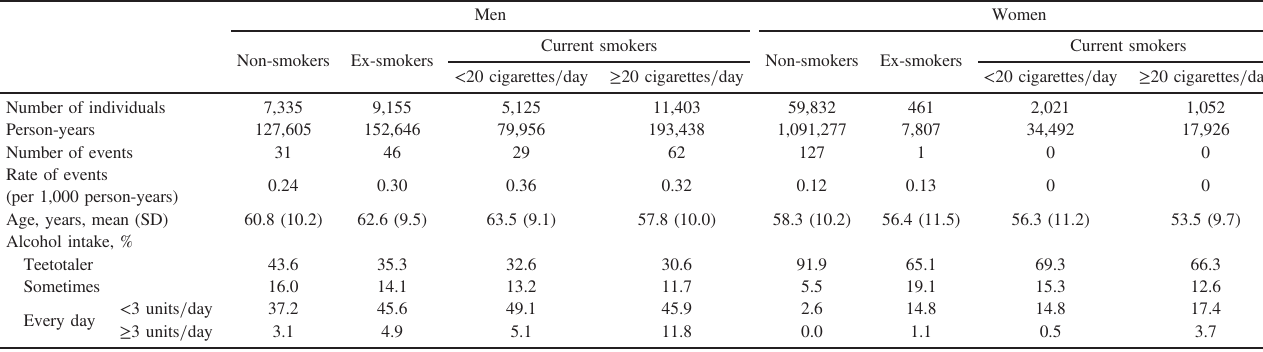
Table 1. Baseline characteristics by smoking status: the Ibaraki Prefectural Health Study